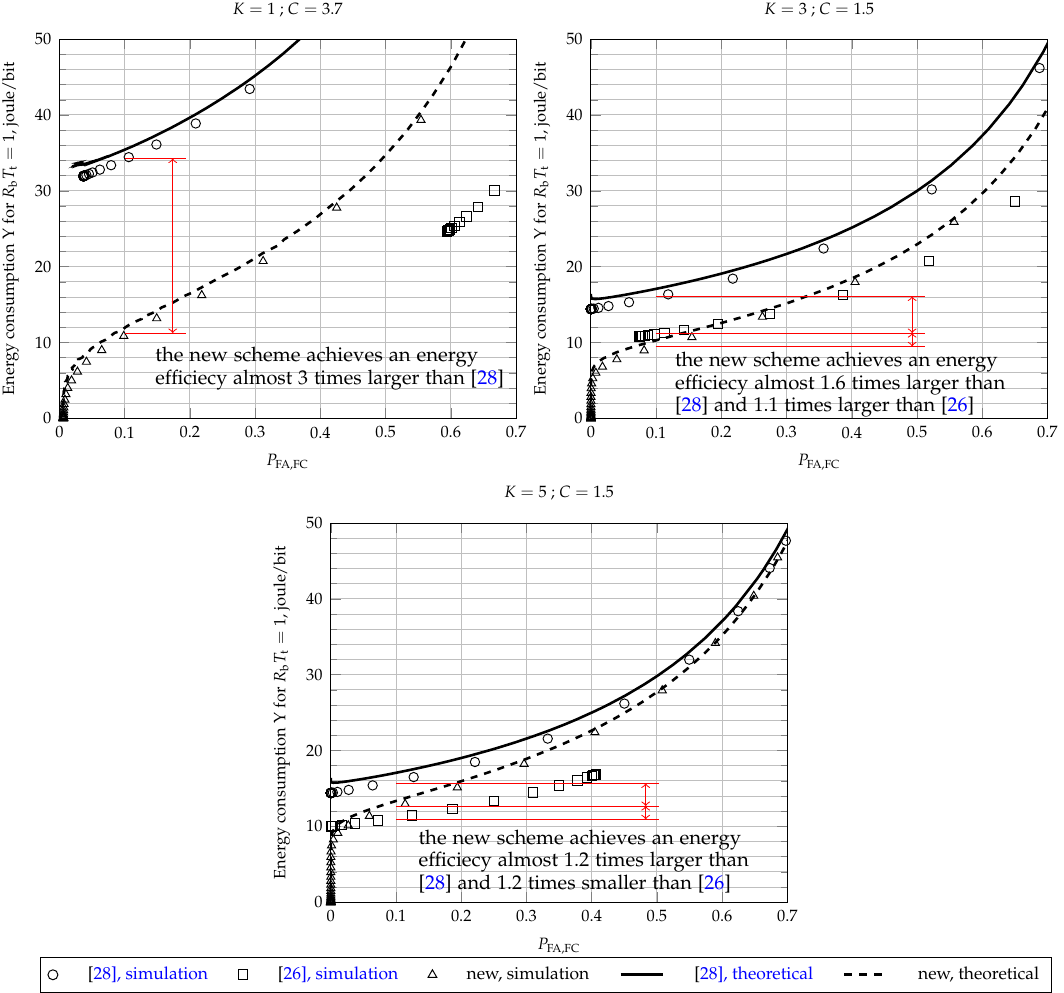
Figure 7. Energy consumption per R b T t fair opportunistic transmitted bits, for M = 5, K = 1 (top-left), K = 3 (top-right) and K = 5 (bottom), γ SU = − 5 dB, γ FC = 5 dB and E = ξ =